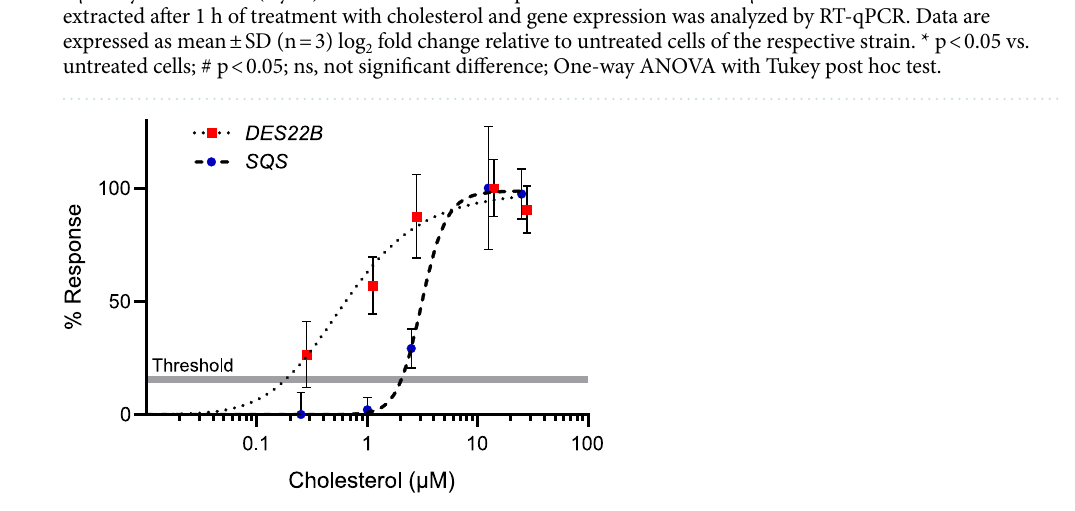
Figure 4. Cholesterol concentration-dependent response curves for the expression of DES22B and SQS in wild - type cells. Cultures were supplemented with different concentrations of cholesterol between 0.25 to 25 µM and RNA was extracted after 1 h for RT-qPCR analysis. Data represent the percentage of the maximum log 2 fold change relative to untreated cells and are shown as mean ± SD (n = 3). Note that although SQS expression is repressed by cholesterol , the response here is plotted as positive values in order to allow a better visualization and comparison of the curves. The grey line indicates the threshold above which expression changes are considered